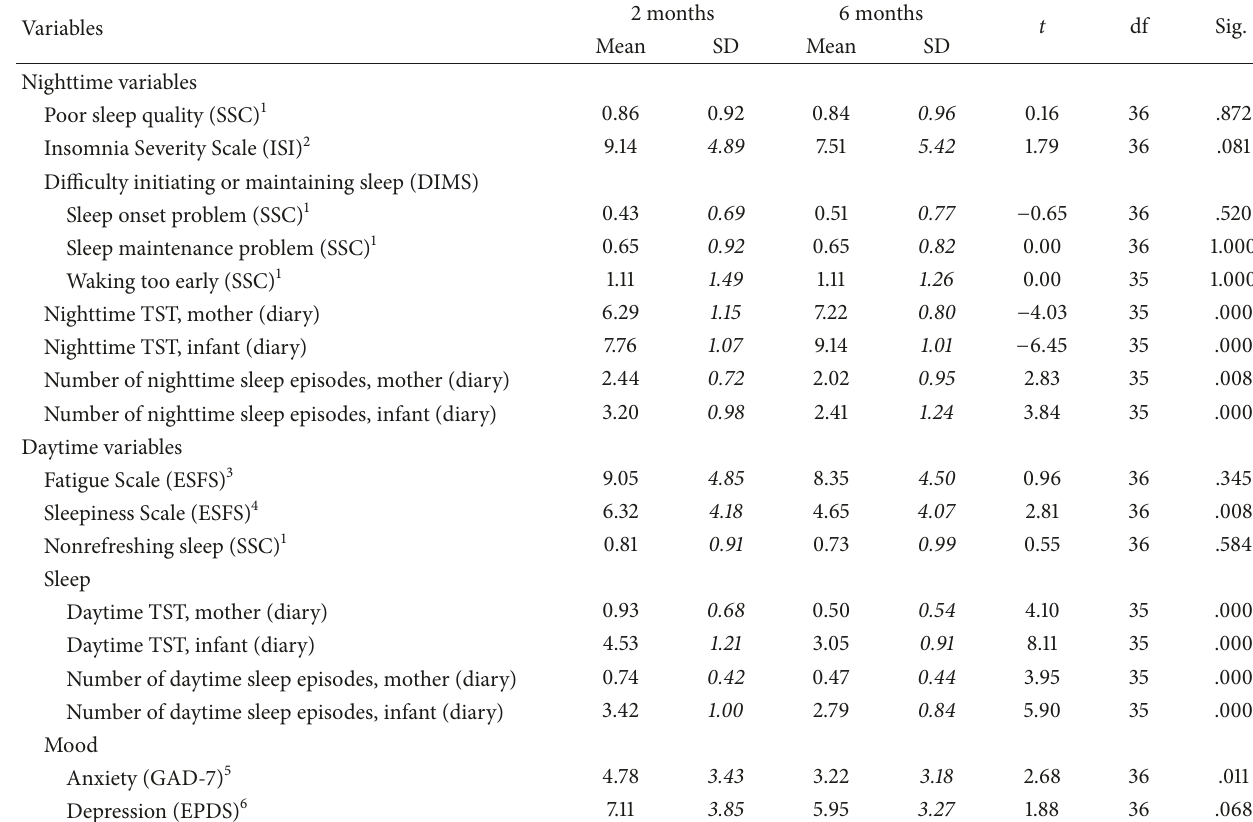
Table 1: Comparisons of 2 and 6 months’ nighttime and daytime